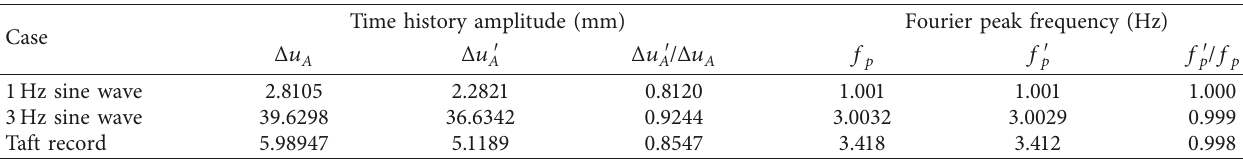
Table 2: Quantitative analysis of results.